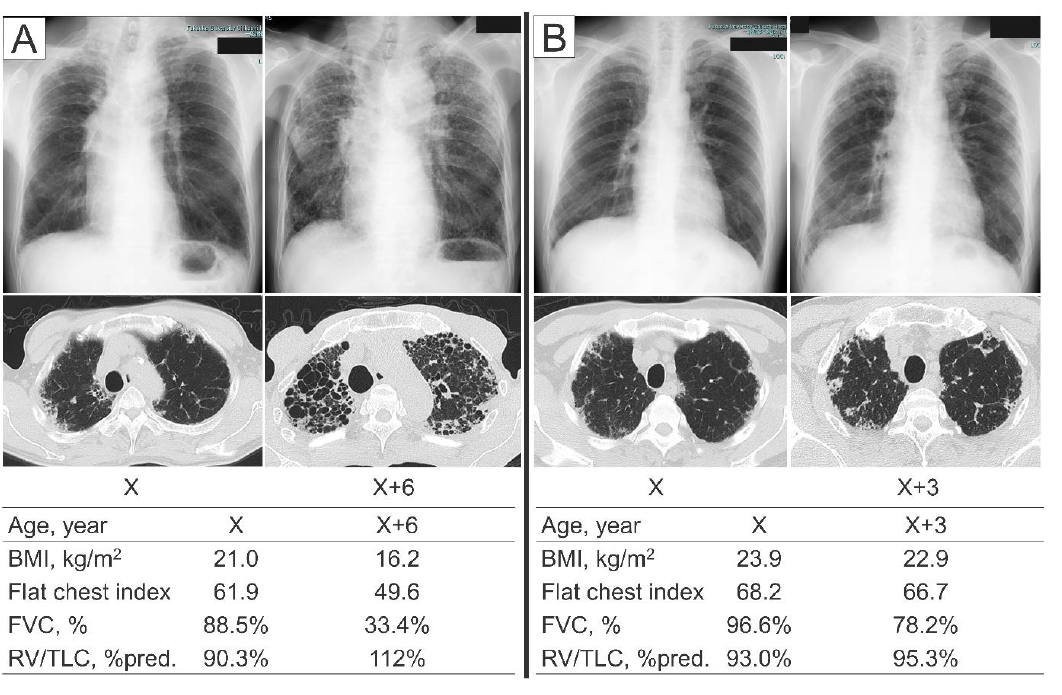
Figure 6. Representative IPPFE patients who did not meet the physiologic criteria at the time of